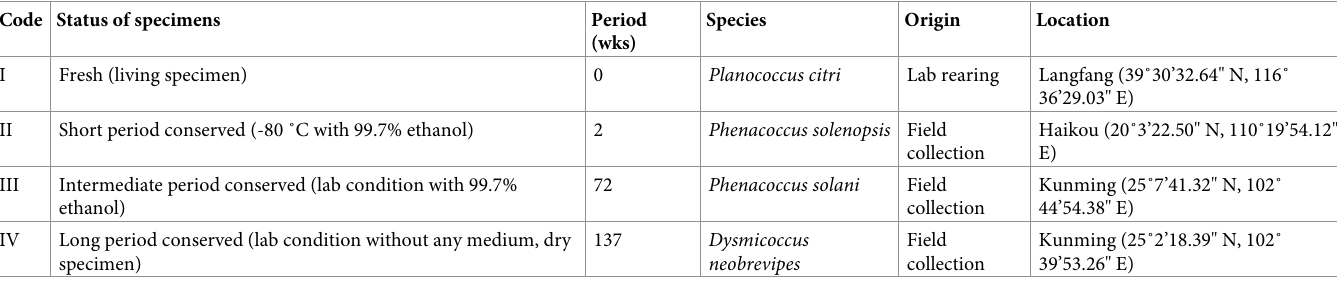
Table 1. Mealybug specimens preserved at different time periods for DNA extraction. Code Status of